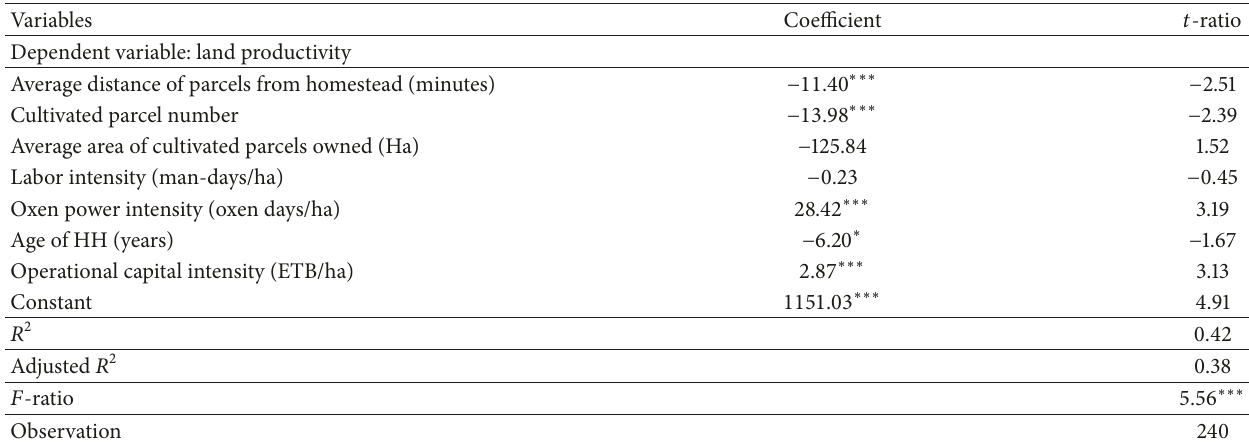
Table 1: Summary of linear regression